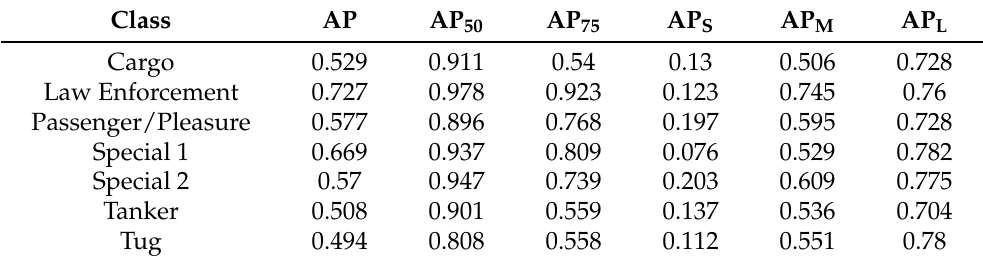
Table A4. Resulting instance segmentation APs per class of the ShipSG dataset using YOLACT 700 , as explained in Section 3.1.